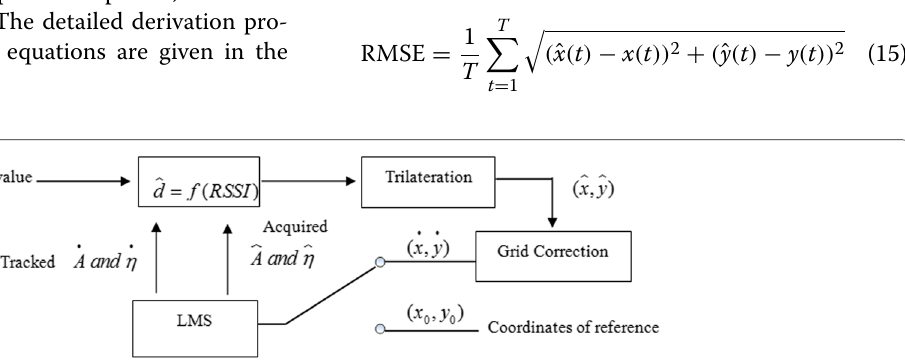
Fig. 6 Diagram of tracking